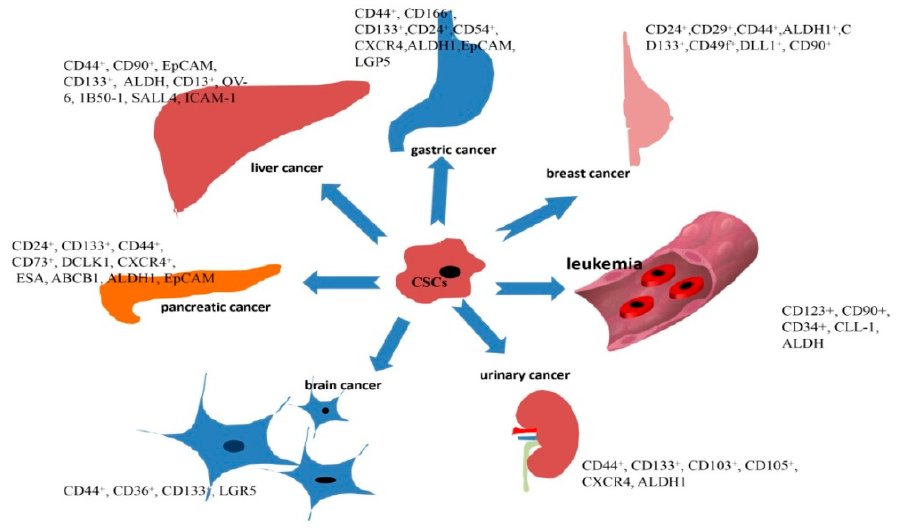
Figure 3. Surface markers expressed on different CSCs.